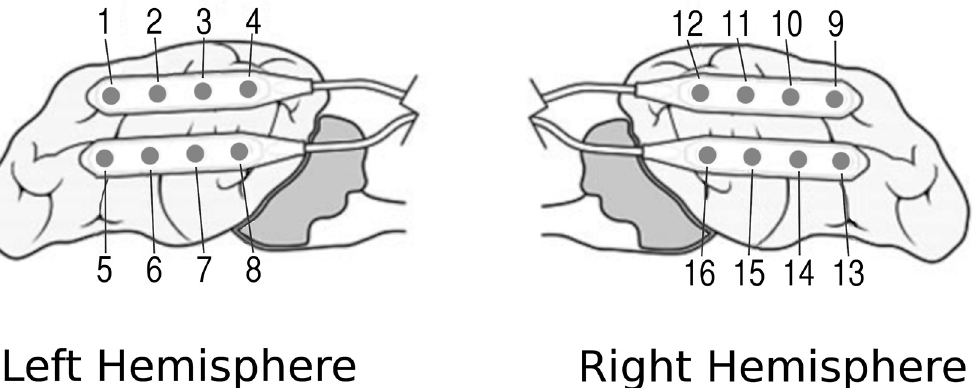
Fig 1. Approximate placement and numbering of sixteen implanted electrode contacts relative to the canine cortical